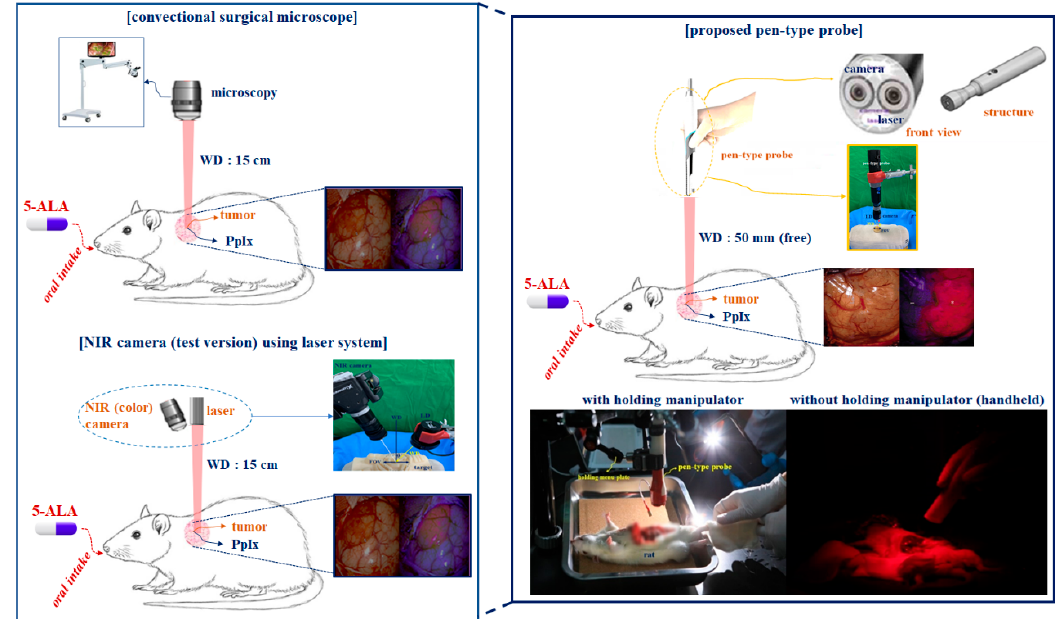
Figure 7. Surgery environment and comparison test for the conventional type and new pen-type probe using a small animal.